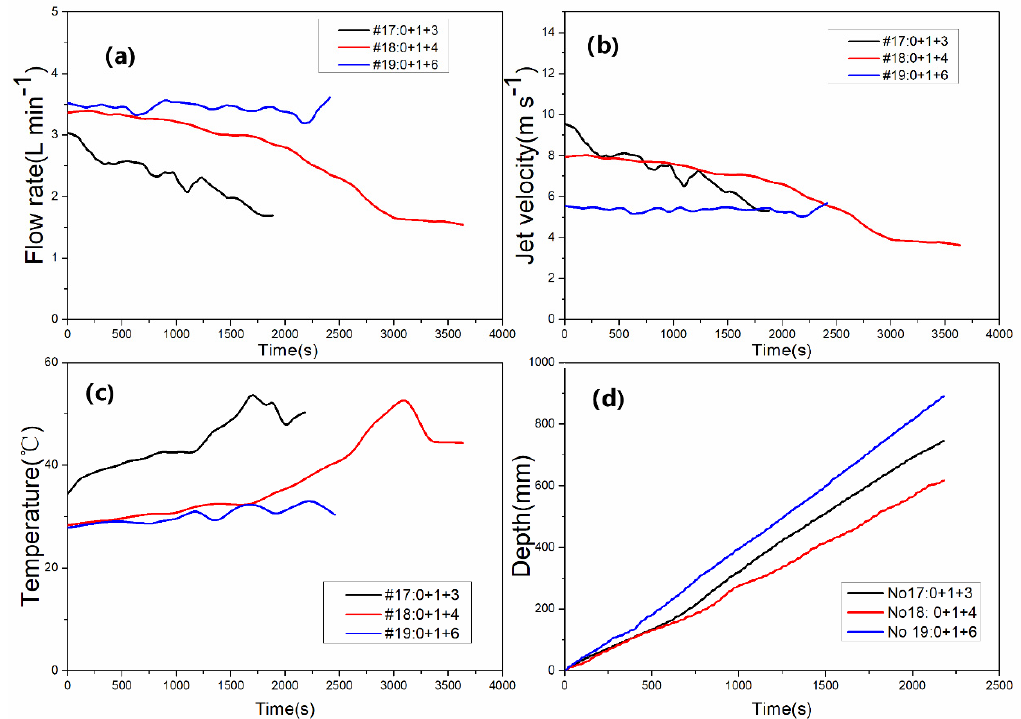
Figure 9. Penetration curves of the nozzles with backward orifices: ( a ) flow rate vs. time; ( b ) jet velocity vs. time;( c ) temperature vs. time; ( d ) depth vs. time.